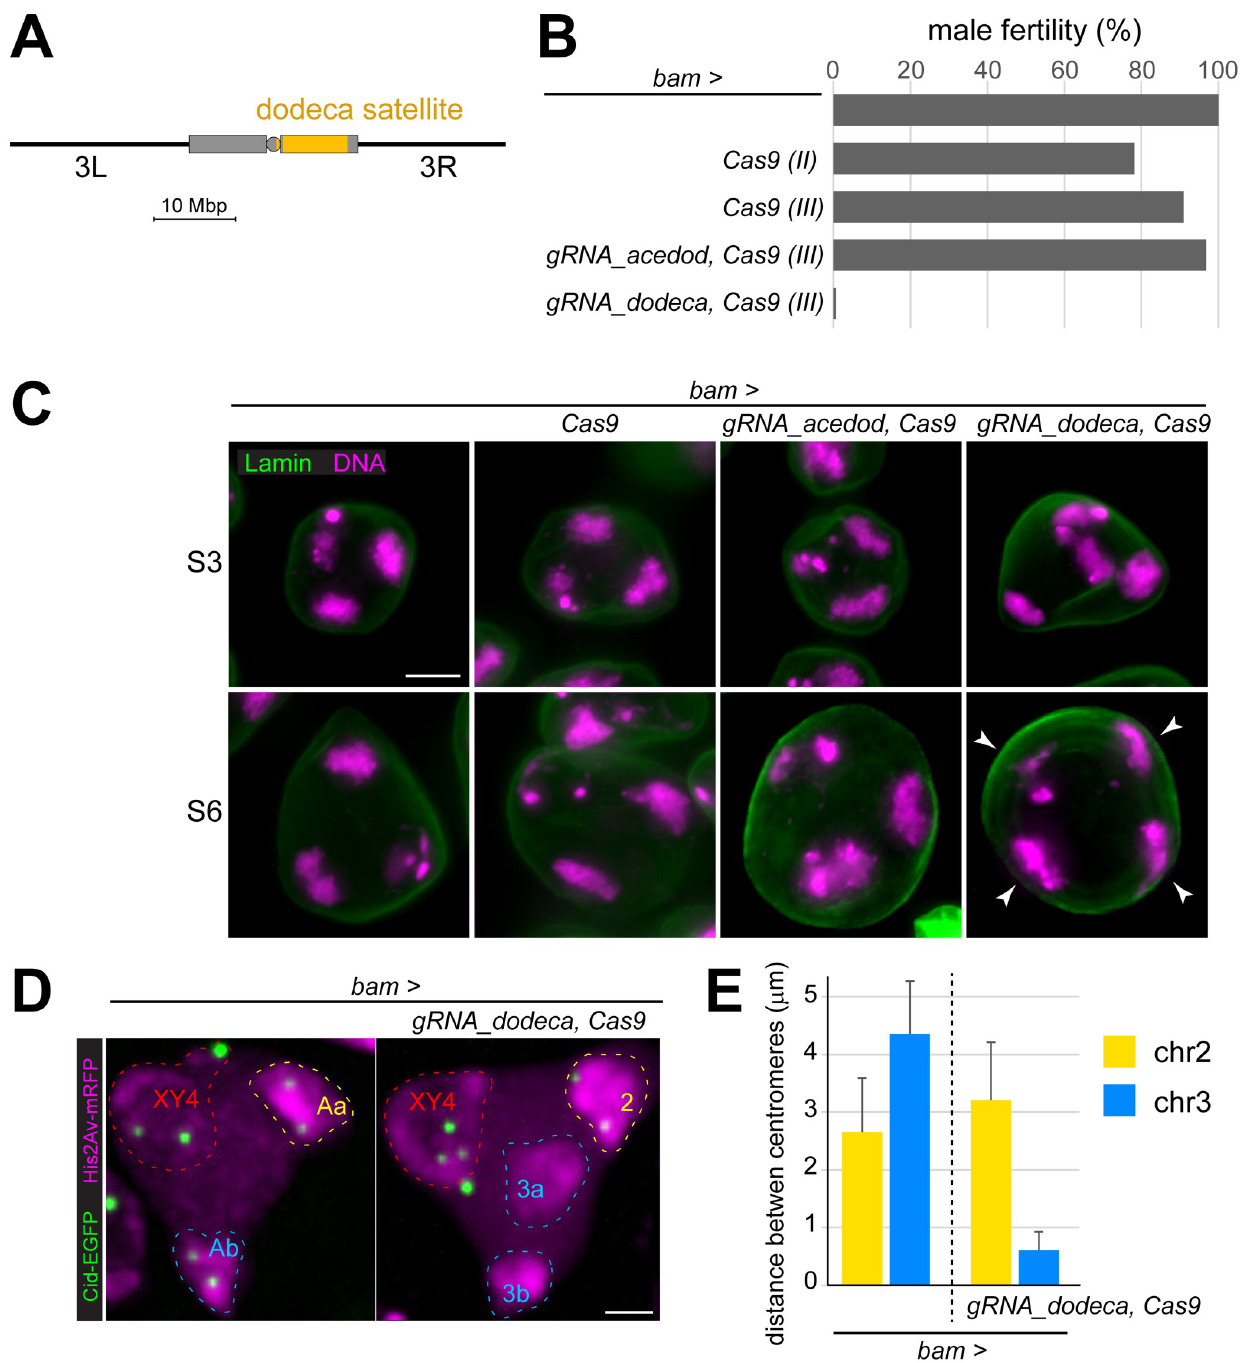
Fig 2. Sub-territory formation after acute cleavage of chr3 by spermatocyte-specific Cas9 targeting to the dodeca satellite repeat. ( A ) Localization of the dodeca satellite. Pericentromeric heterochromatin represented by boxes, centromere by circle. ( B ) Horizontal bars indicate fertility of males, in which bam-GAL4-VP16 ( bam > ) was used for spermatocyte-specific expression of the indicated UAS transgenes. The fertility of bam-GAL4-VP16 males without a UAS transgene was set to 100% (top). Co-expression of Cas9 and a gRNA targeting the dodeca satellite sequence resulted in almost complete sterility (bottom). ( C ) Spermatocytes with bam-GAL4-VP16 ( bam > ) and the indicated UAS transgenes after labeling testis squash preparations with anti- LaminDm0 and a DNA stain. High magnification views display cells soon after chromosome territory formation (S3) and with maximally separated territories (S6). Four major chromosome territories (arrowheads) instead of the normal three were observed in mature spermatocytes after dodeca satellite cutting. ( D,E ) Chromosome territory organization analyzed by live imaging of spermatocytes expressing His2Av-mRFP and Cenp-A/cid-EGFP . ( D ) Territories in S6 cells without or with bam > UAS-Cas9 UAS-gRNA_dodeca are indicated (dashed lines). Targeting of the dodeca satellite results in the